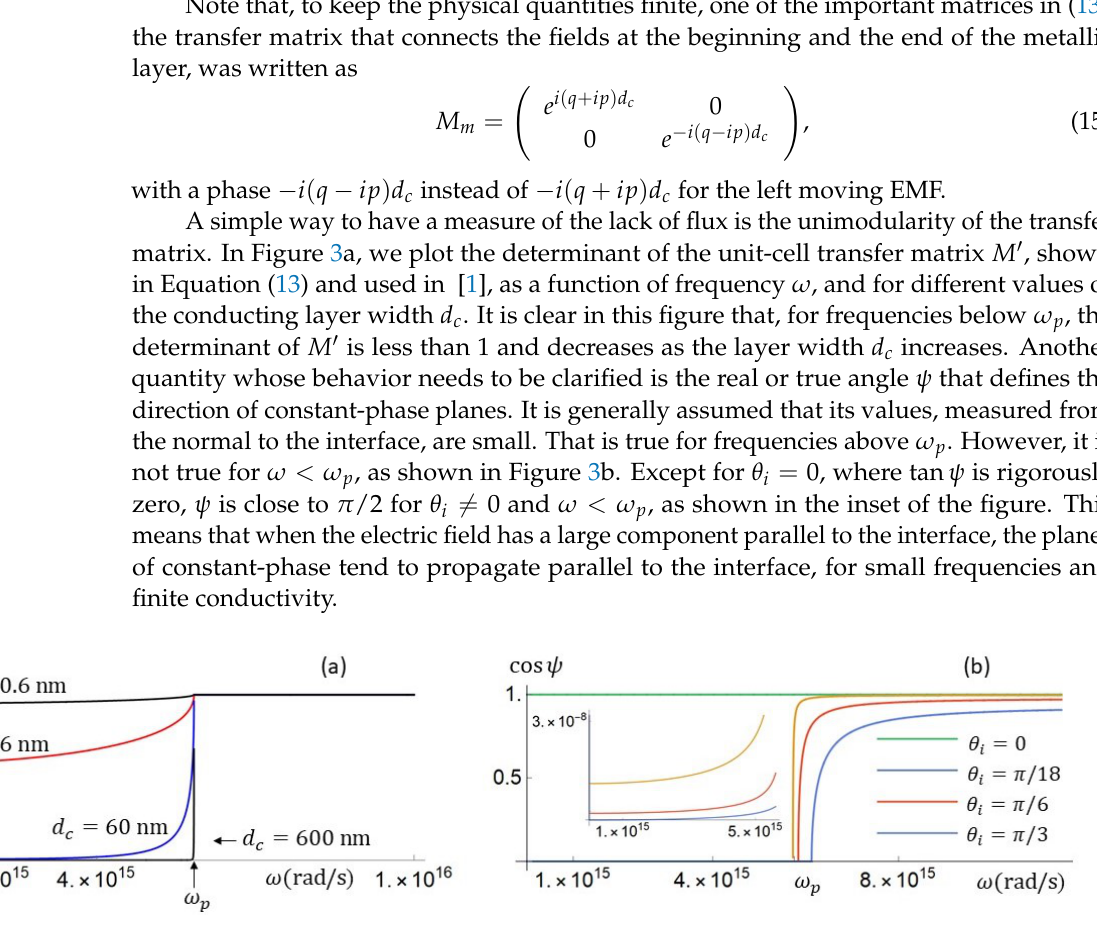
Figure 3. Determinant of the transfer matrix M (cid:48) c in (13), and the real angle as functions of frequency, conductor layer width, and incidence angle. ( a ) The determinant of the unit-cell transfer matrix, det M (cid:48) c , decreases as the conductor layer width d c increases. ( b ) The cosine of the real angle ψ : We show here that even though that for ω > ω p it is close to 1 (as is well known), for ω < ω p it is close to zero, except for θ i =